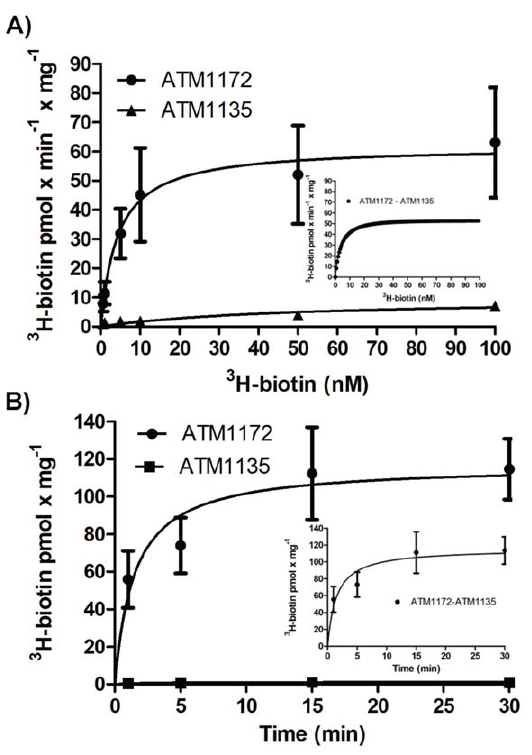
Figure 4. Transport of 3 H-biotin in E.coli mediated by Chlamydia BioY. BioY transport kinetics were determined in (A) by incubating E. coli ATM1172 and E. coli ATM1135 with 0.5, 1, 5, 10, 50, or 100 nM 3 H- biotin for one minute at 30 u C. Reactions were halted and the amount of radioactivity present in the sample was measured using a scintillation counter. Data were plotted and analyzed using GraphPad 5.0. In (B), E. coli ATM1172 and E. coli ATM1135 were incubated with 100 nM 3 H- biotin at 30 u C for 1, 5, 15, or 30 minutes. The inserts in (A) and (B) show corrected values after subtracting E. coli ATM1135 background levels.